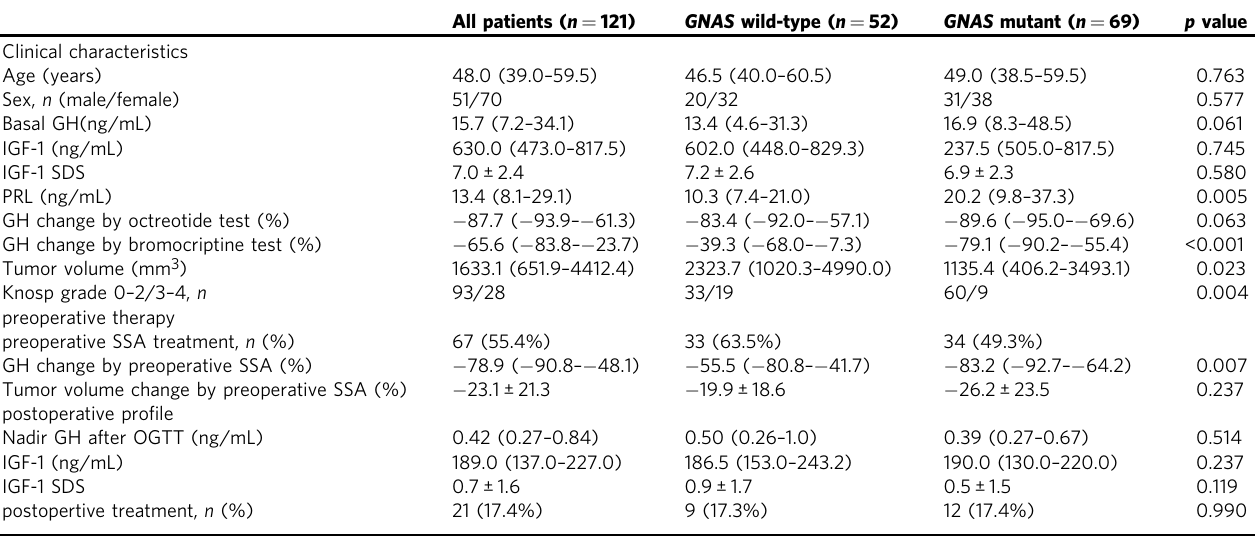
Table 1 Clinical characteristics of GH-producing pituitary adenoma/ somatotroph pituitary neuroendocrine tumor patients and comparison of those with wild-type versus mutant GNAS